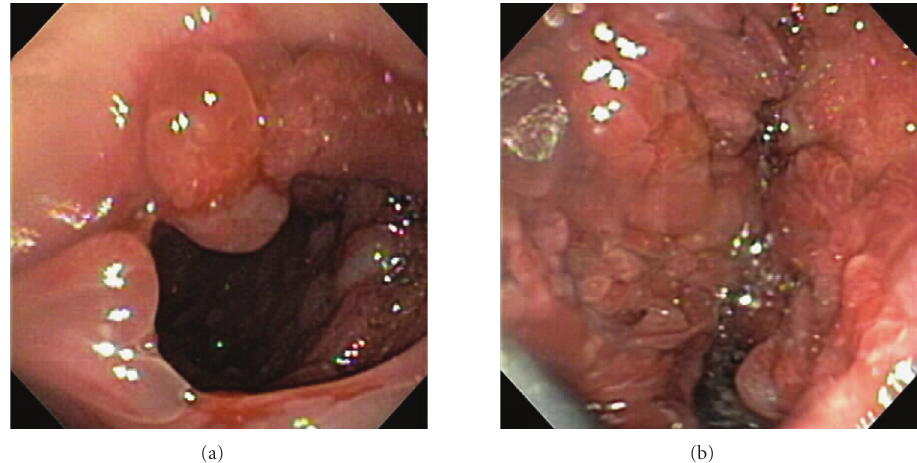
Figure 2: (a) Image obtained during upper endoscopy of the stomach demonstrates multiple polyps and edematous mucosa. (b) Image obtained during upper endoscopy of the stomach demonstrates numerous polyps which coalesce, giving a mass-like